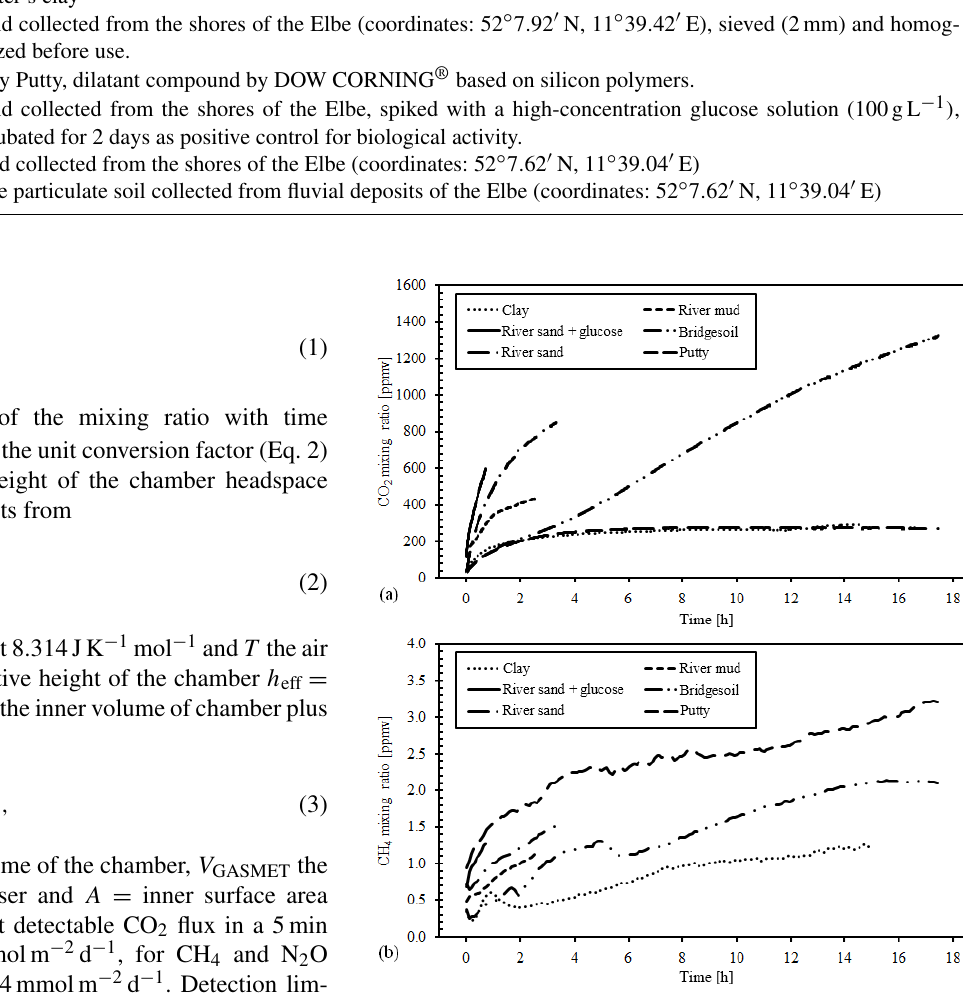
Figure 1. CO 2 (a) and CH 4 (b) mixing ratio during long-term lab- oratory chamber experiments with different sealing